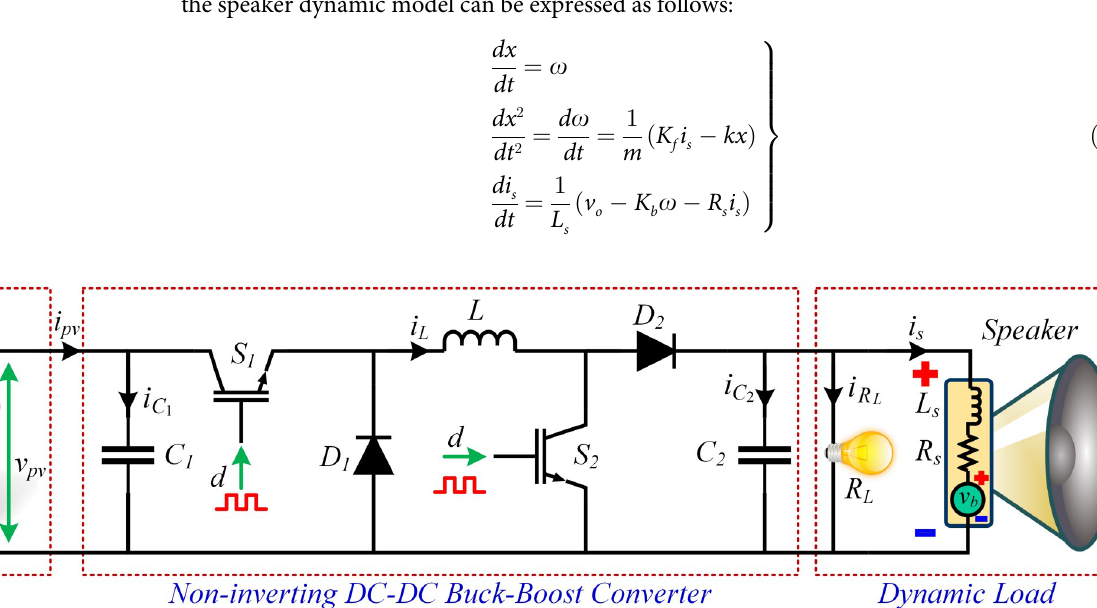
PLOS ONE | https://doi.org/10.1371/journal.pone.0231749 May 19,